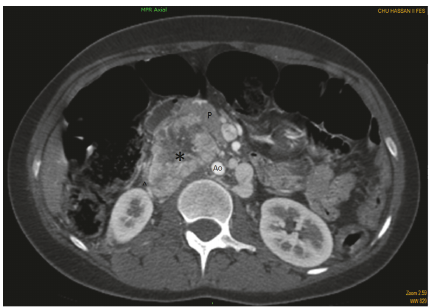
Figure 1: A contrast abdominal CT scan showing a 7.0 x 5.0 cm heterogeneous mass (black asterisk) located between the abdominal aorta (Ao) and the inferior vena cava, pushing the head of the pancreas